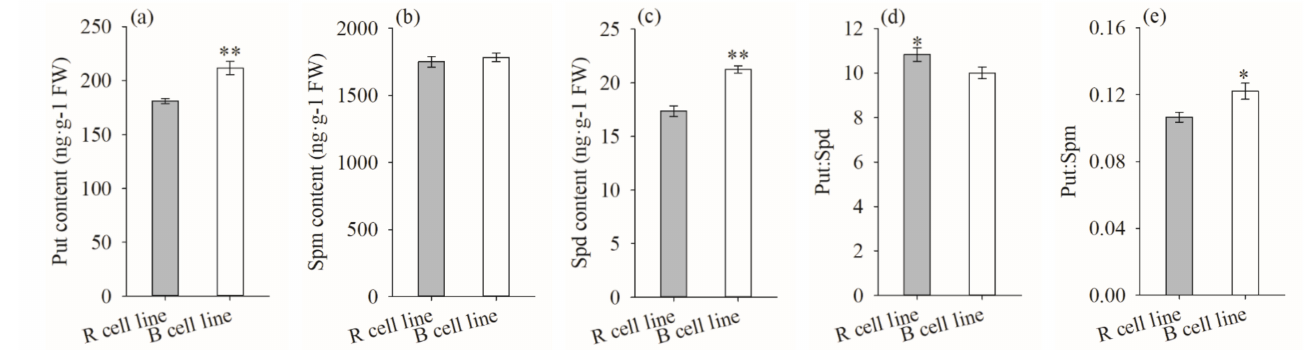
Figure 12. Differences in Put, Spm, and Spd contents, as well as the Put: Spd and Put: Spm ratios between P. koraiensis R and B cell lines. ** above the column indicates that the difference is significant at the p < 0.01 level, and * above the column indicates that the difference is significant at the p < 0.05 level.